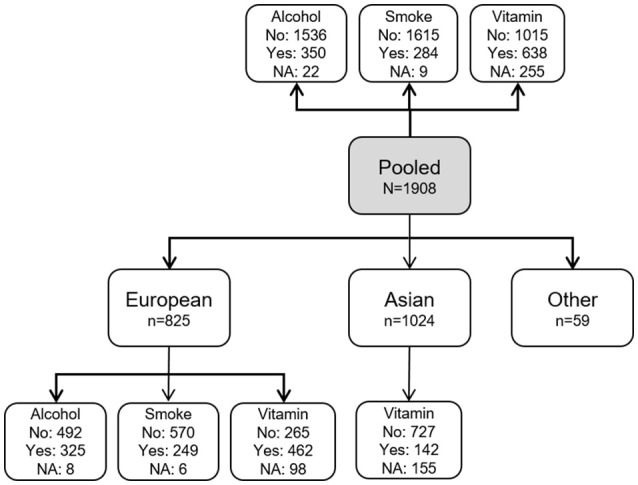
Distribution of families according to ethnicity and maternal exposure status. The gray box shows the pooled sample consisting of all ethnicities (N = 1,908). White boxes show the number of families according to ethnicity and exposure (yes: exposed; no: unexposed; NA: data not available). Note that we did not consider GxSmoke or GxAlcohol analyses in the Asian sample because of a very low number of observations for these exposures.